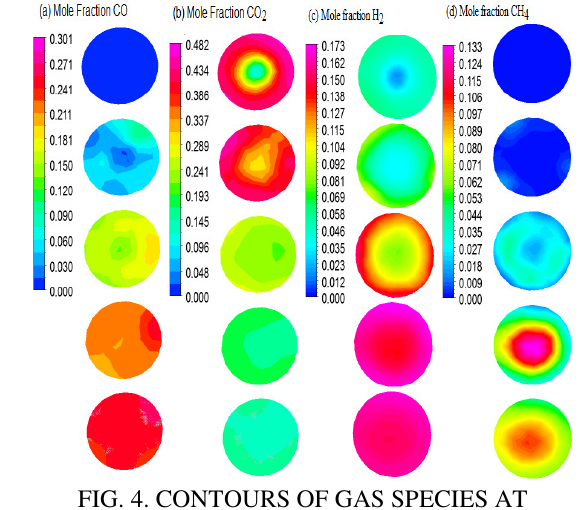
FIG. 4. CONTOURS OF GAS SPECIES